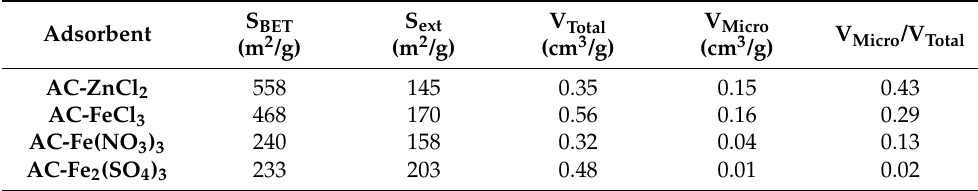
Table 2. Textural properties of the carbon